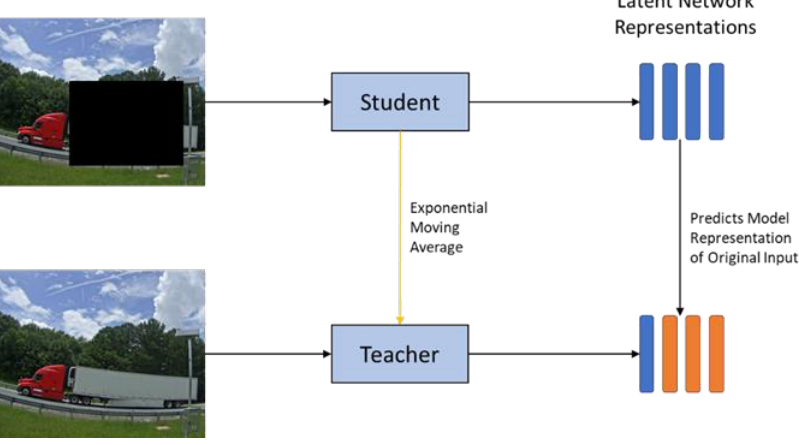
Figure 6. Illustration of data2vec.